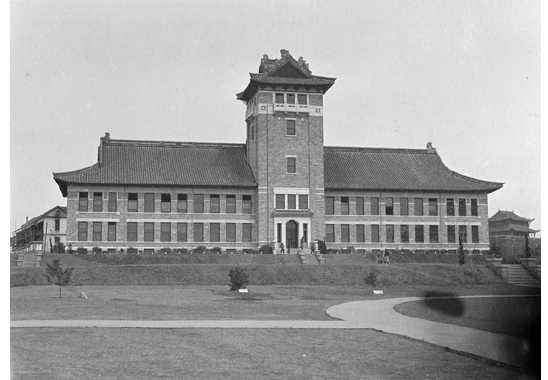
Figure 1. The North Building of the University of Nanking.